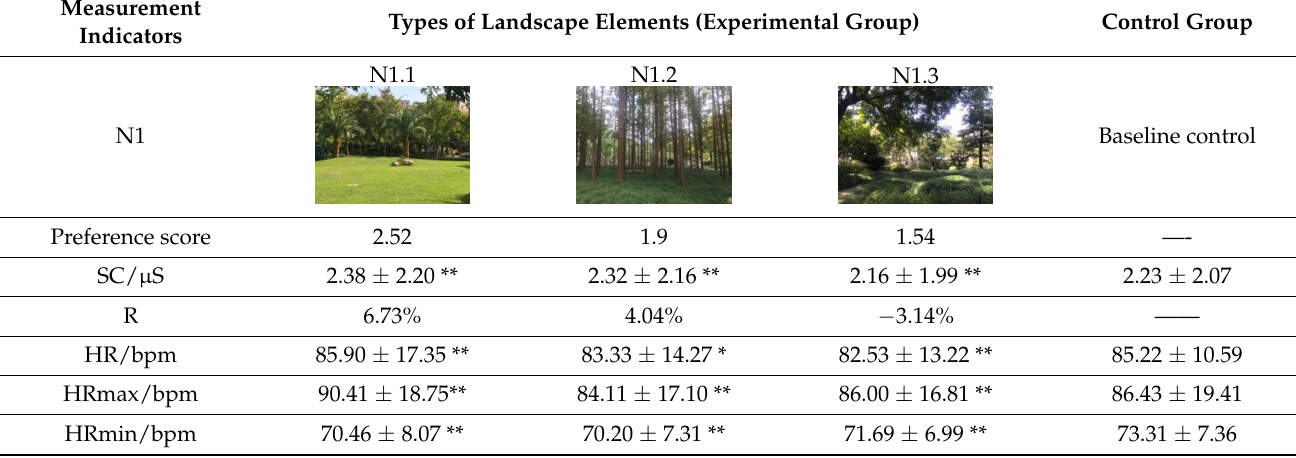
significance at a level of p < 0.01.